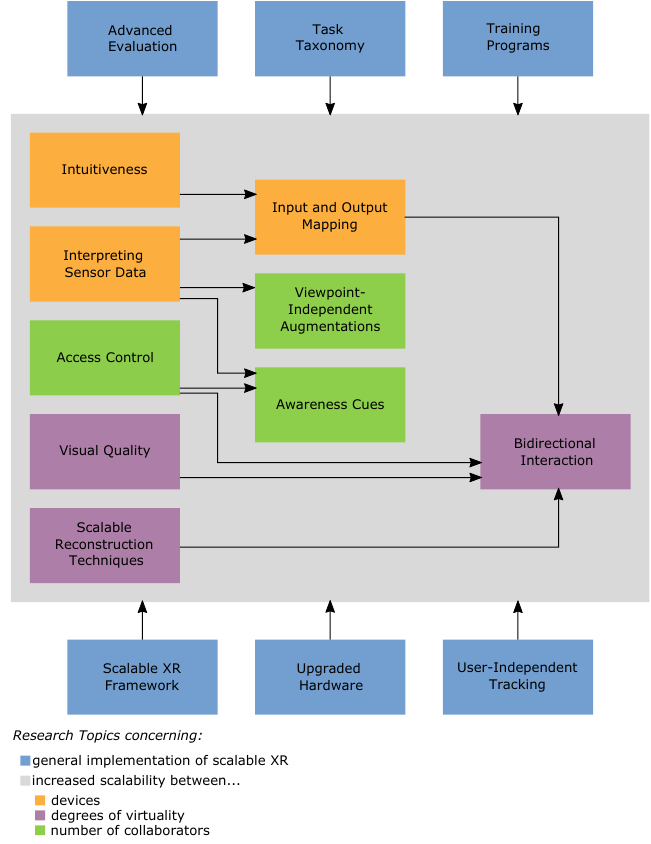
Figure 3. Research topics that are relevant to the development of XR S spaces and expected contribu- tions among